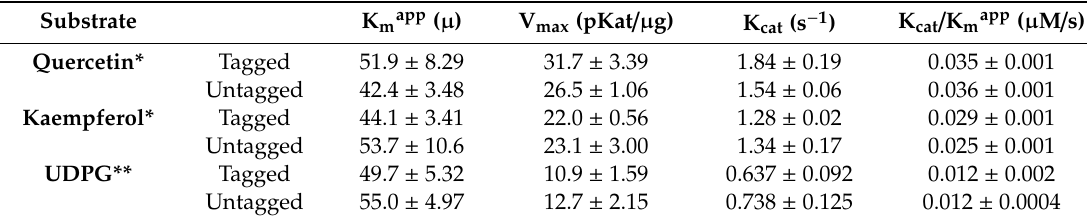
Table 1. Kinetics on tagged and untagged Cp3GT with three substrates. Values are expressed as mean ± SD. *Average of 2 experiments ( n = 2) **Average of 6 experiments ( n = 2). UDPG = Uridine